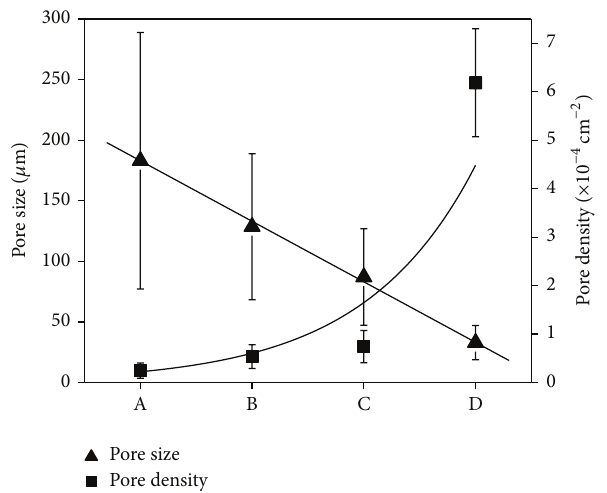
Figure 2: Pore size and pore density of different scaffolds.